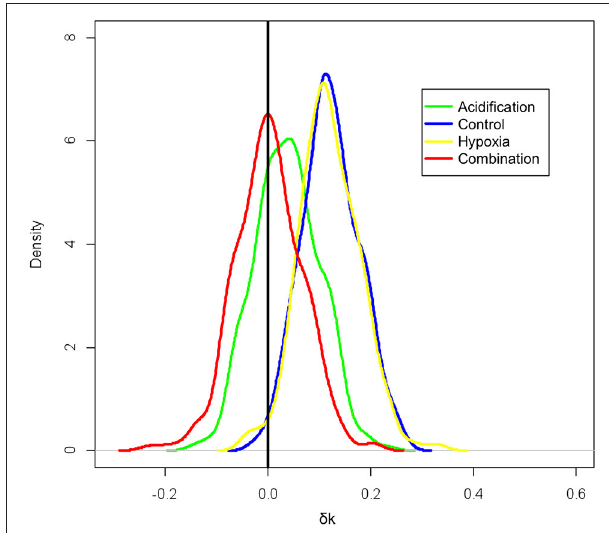
FIGURE 2 | Tendency of the fish to remain close to the refuge: increase in k indicates the tendency to move to and remain close to the refuge; a decrease toward zero means the movement pattern approaches a (i.e., unbiased) random walk, and a negative k shows that the fish tend to avoid the